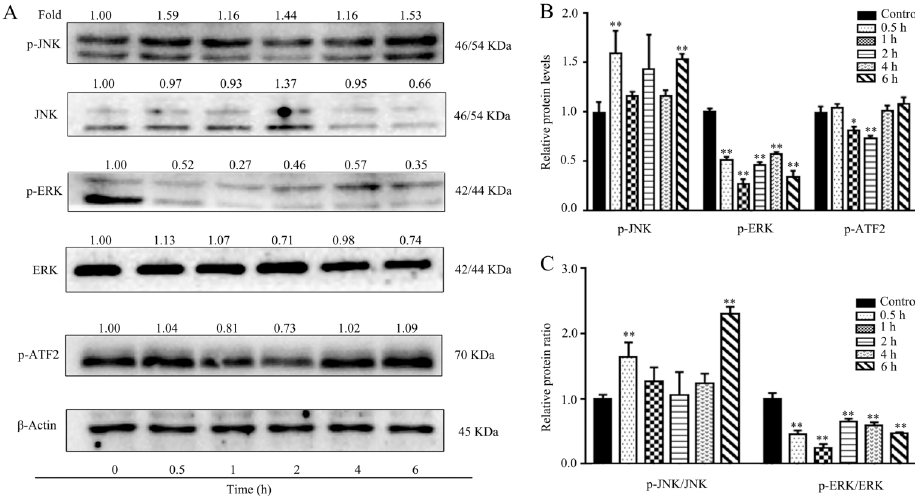
Figure 5. Effect of Tan I on JNK and ERK signaling pathways in K562 cells at different treatment times. A , Related protein expression was measured using western blotting. B , The relative protein levels of p-JNK, p-ERK, and p-ATF2 were quanti fi ed using Image Lab software. C , The relative protein level ratios of p-JNK/JNK and p-ERK/ERK. Data are reported as means ± SD. *P o 0.05 and **P o 0.01 compared with the corresponding control group